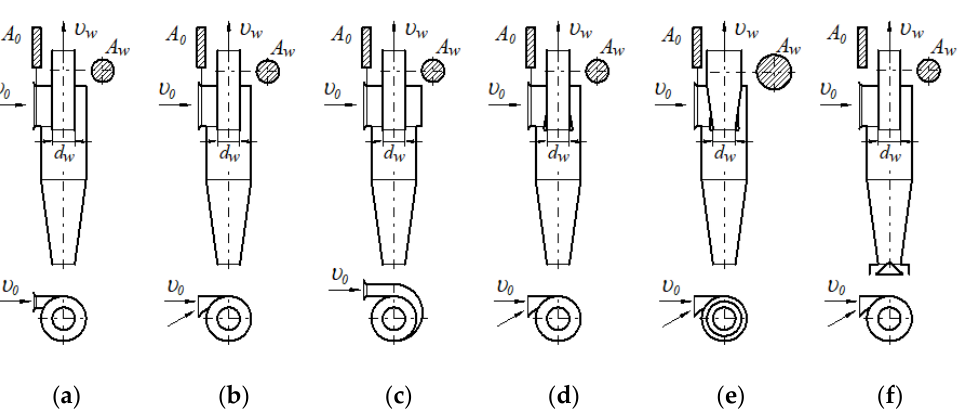
Figure 24. Possible changes in the design of cyclone D -40: ( a ) original version, ( b ) changing the shape of the inlet from symmetrical to asymmetrical, ( c ) using a spiral inlet described on the cyclone’s hull, ( d ) giving a streamlined shape to the edges of the inlet opening of the outlet pipe, ( e ) changing the cylindrical outlet pipe into a conical one and ( f ) using a special protective cone in the lower part of the